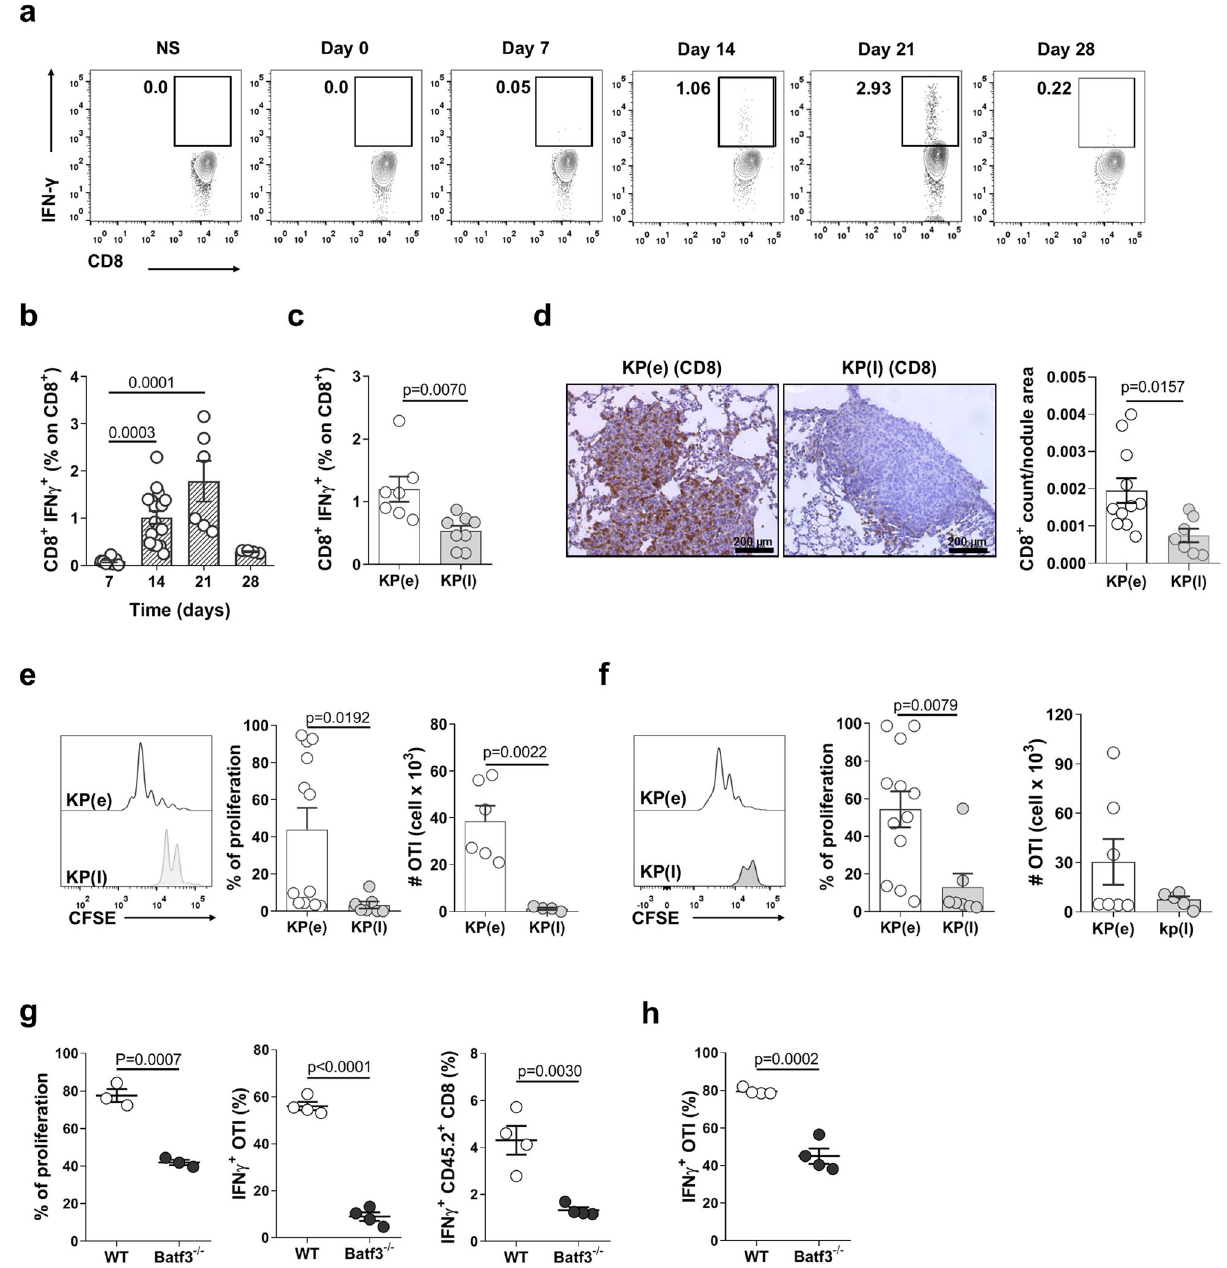
Fig. 2 CD8 + T cell responses and cross-presentation of tumor antigens by cDC1 are inhibited in late tumors. a , b Representative plots and quanti fi cation of the kinetic of IFN- γ production by endogenous blood CD8 + T cells in KP-OVA challenged mice. Data are from two independent experiments at day 7 – 28 or 3 independent experiments at day 14 – 21. In b Kruskal – Wallis followed by Dunn ’ s post-test day 7 n = 6, day 14 n = 15, day 21 n = 6, day 28 n = 4 mice. c Percentage of IFN- γ producing endogenous CD8 + T cells in lungs bearing early or late KP-OVA tumors. KP(e) n = 7, KP(l) n = 8 mice in two independent experiments, two-tailed unpaired t -test. d CD8 + T cells localization in early and late KP-OVA tumors. Scale bar 200 µ m. Quanti fi cation of the density of CD8 + T cells as a function of the nodule area was calculated automatically on three consecutive sections/sample. Data are from KP(e) n = 11, KP(l) n = 7, two-tailed unpaired t -test. e , f Proliferation pro fi le of OT-I in the MLN ( e ) or lung ( f ) of mice bearing early or late KP-OVA tumors was measured 2 days after transfer. Proliferation index (cells that underwent at least two cycles of proliferation) and absolute numbers of proliferated cells are depicted. In e % of proliferation KP(e) n = 12, KP(l) n = 7; absolute numbers KP(e) n = 6, KP(l) n = 4. In f %proliferation KP(e) n = 12, KP(l) n = 7; absolute numbers KP(e) n = 7, KP(l) n = 5. Data are from three independent experiments, two-tailed unpaired t -test. g , h KP-OVA tumors were induced in WT and Batf3 − / − mice. g Proliferation and IFN- γ production of adoptively transferred OVA speci fi c CD8 T cells and IFN- γ production by endogenous CD8 + T cells in the lung. % proliferation WT n = 3, Batf3 − / − n = 3; IFN γ + OTI (%) and IFN γ + CD45.2 + CD8(%) WT n = 4, Batf3 − / − n = 4; two-tailed unpaired t -test. h IFN- γ production by OT-I in MLNs. Data represent one of two independent experiments ( n = 4 mice/group), two-tailed unpaired t -test. All data are expressed as mean ± SEM. Source data are provided as a Source Data fi le.